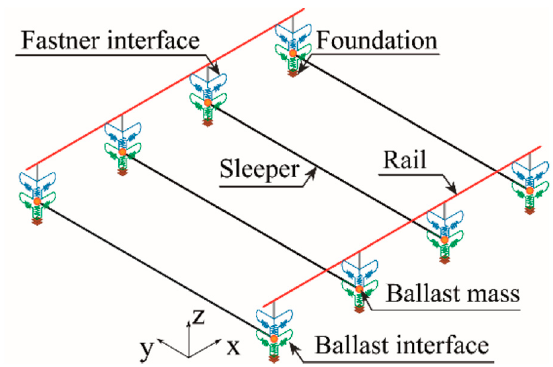
Figure 4. 3D FE model of the track. Table 2. Mechanical properties of the track. Table 2. Mechanical properties of the